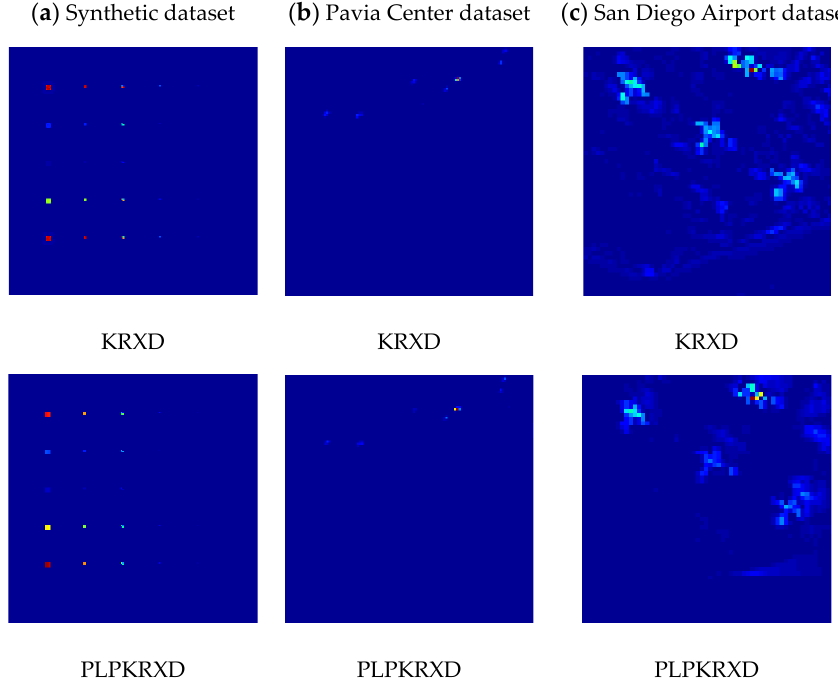
Figure 12. The detection maps of the KRXD and the PLP-KRXD on the three HSI datasets. ( a ) Synthetic dataset; ( b ) Pavia Center dataset; ( c ) San Diego Airport dataset.